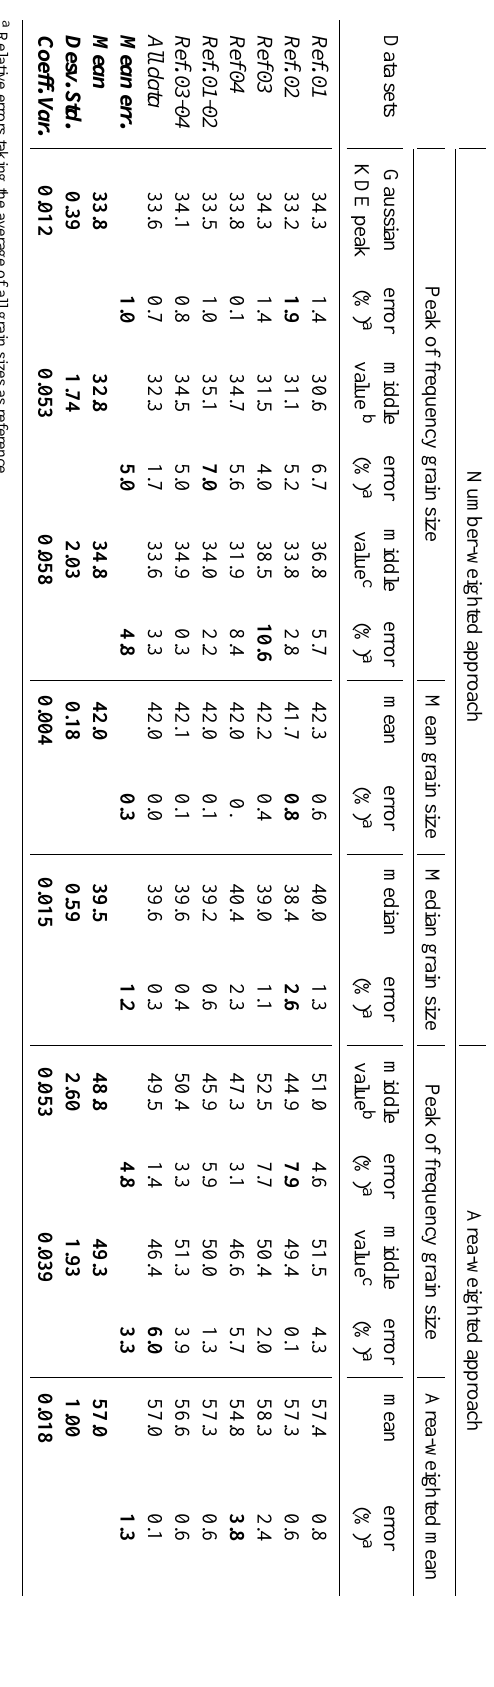
mean yielded similar results in average (1.0–1.3 %), while the mean yielded in this case slightly better results (0.3